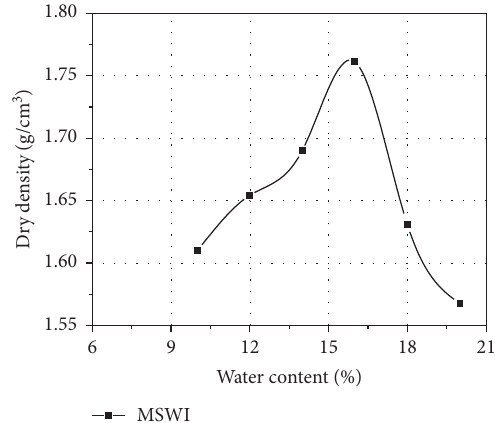
Figure 3: Compaction curves for MSWI.